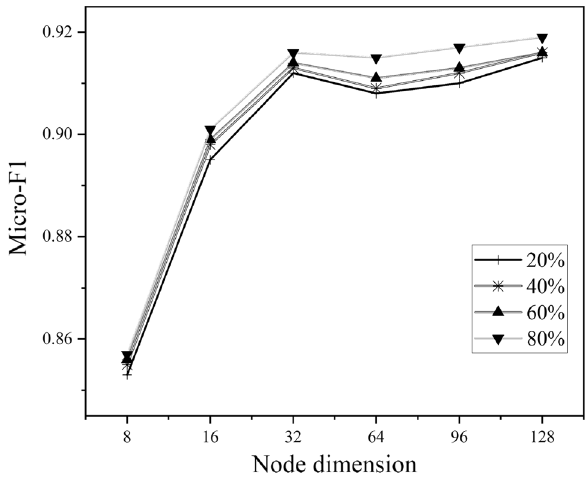
Figure 5. Hyperparameter sensitivity analysis on ACM.